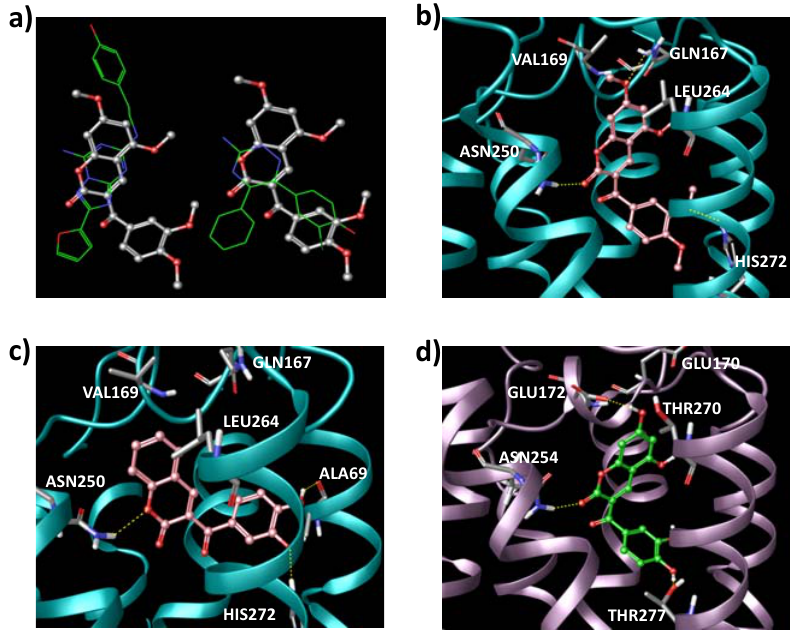
Figure 2. ( a ) Comparative study of the co ‐ crystallized ligands (green carbons) in the h A 2A [3EML (left) and 3UZC (right)] with the pose of compound 3 extracted from the h A 3 docking calculations (grey carbons). Binding pockets in h A 2A and h A 3 were superposed. ( b ) Pose extracted for compound 3 inside the h A 3 after docking. Hydrogen bonds are represented in yellow color. ( c ) Hypothetical binding mode for compound 5 (pink carbons) in the h A 3 . ( d ) Pose obtained through docking simulations for compound 7 (green carbons) in the h A 1 protein pocket.